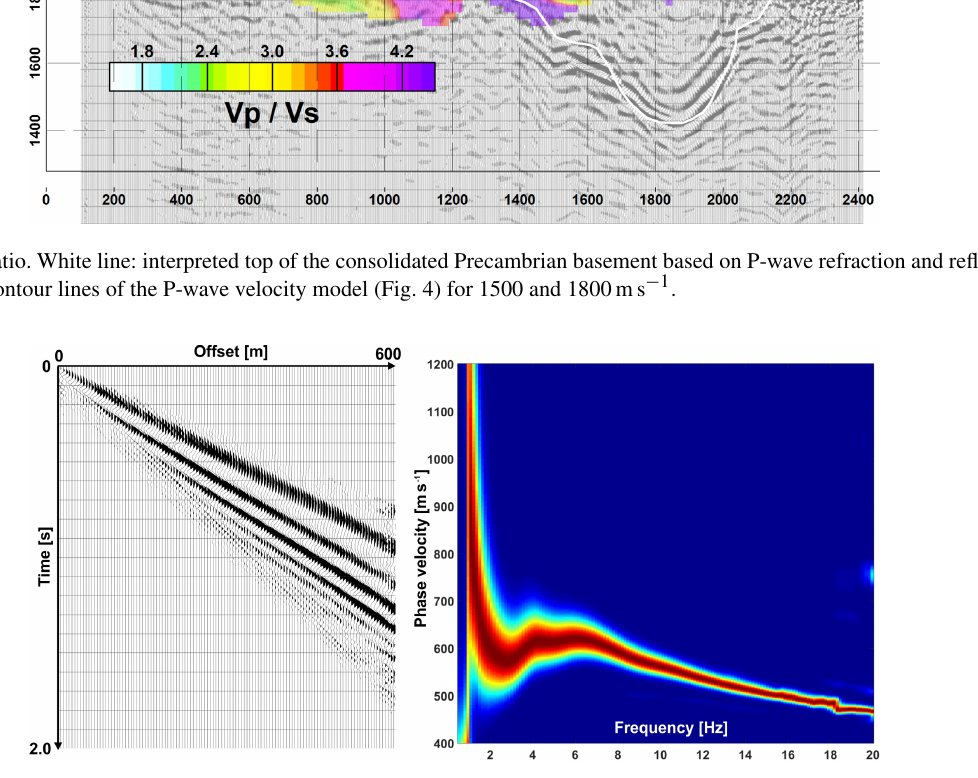
Figure 10. Dispersion curve obtained from source–receiver sorting and offset stacking of all virtual source gathers within the over-deepened section (profile distance